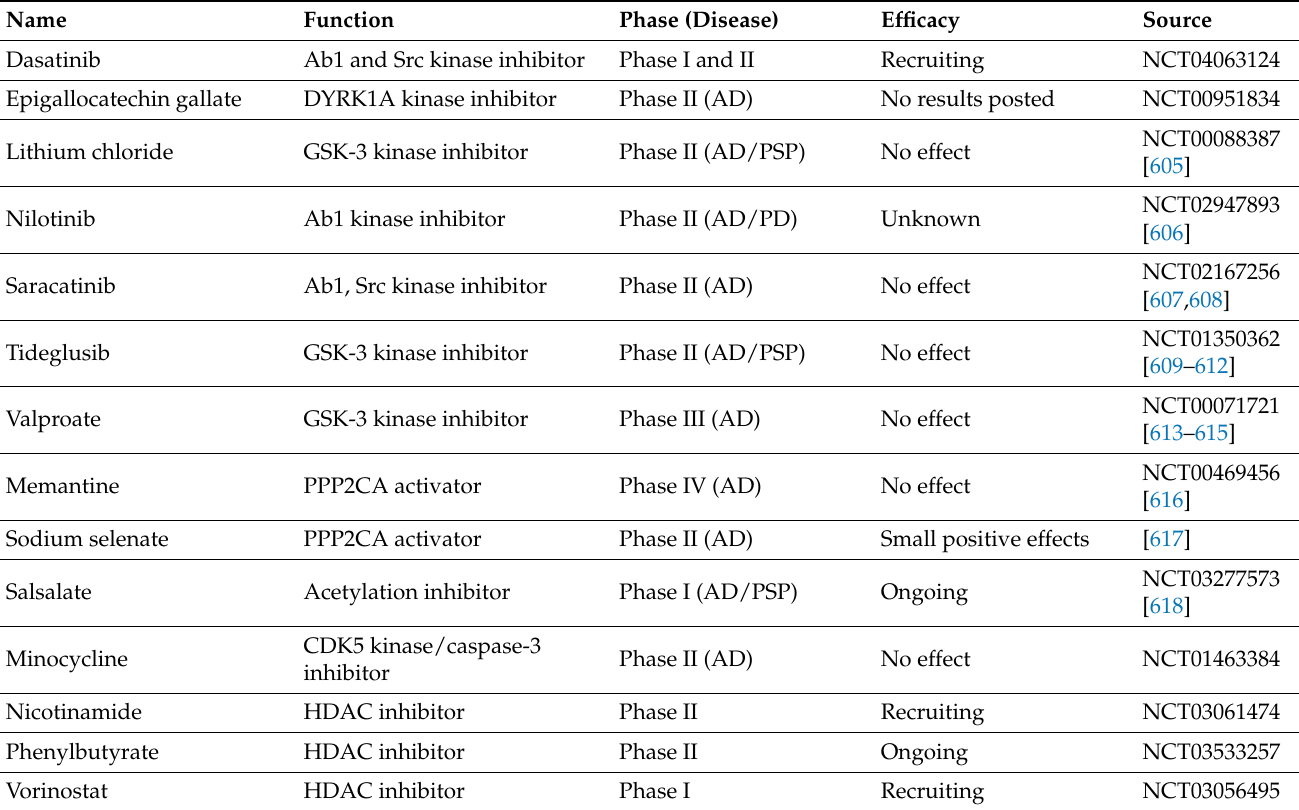
Table 5. Compounds in clinical trials targeting tau interactions with its